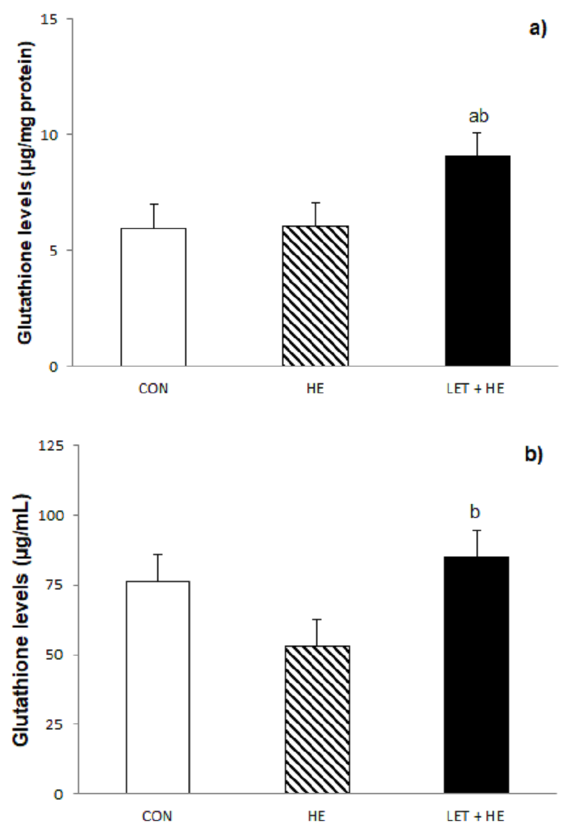
Figure 3. a) Vastus intermedius muscle and b) plasma glutathione levels of the groups. Data are expressed as mean ± SD. a P < 0.05 compared to the CON group and b P < 0.05 compared to the HE group. CON: Control group, HE: High-intensity eccentric exercise group, LET + HE: Low-intensity eccentric exercise training plus high-intensity eccentric exercise